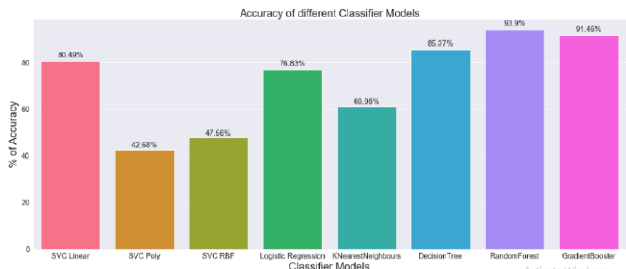
Figure 26. Machine Learning Classification Models